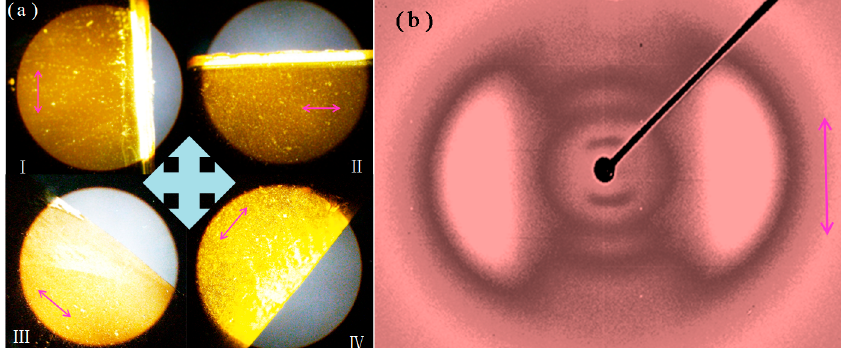
Figure 3. ( a ) POMs of the AZO-CLCP film(F20): (I) The rubbing direction is parallel to the vertical polarization direction; (II) The rubbing direction is parallel to the horizontal polarization direction; (III) The angle between the rubbing direction and the polarization direction of either polarizer is − 45 ◦ ; (IV) The angle between the rubbing direction and the polarization direction of either polarizer is 45 ◦ . Inserted crossarrows illustrate the polarization directions of the two polarizers, and the pink arrows illustrate the rubbing directions; ( b ) 2D-WAXS pattern of the AZO-CLCP / CNT nanocomposite film (CF20). Inserted pink arrow illustrates the rubbing